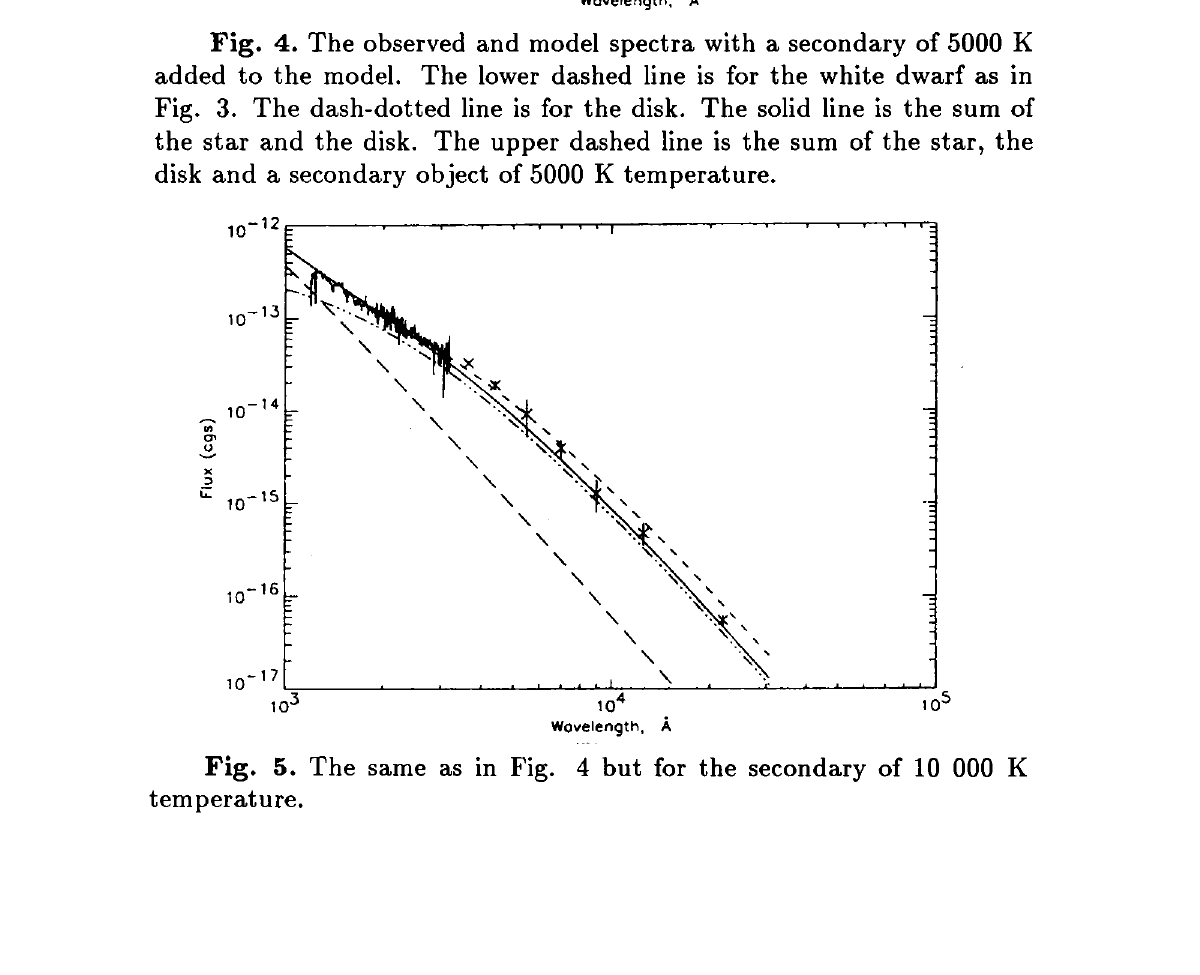
Fig. 5. The same as in Fig. 4 but for the secondary of 10 000 K